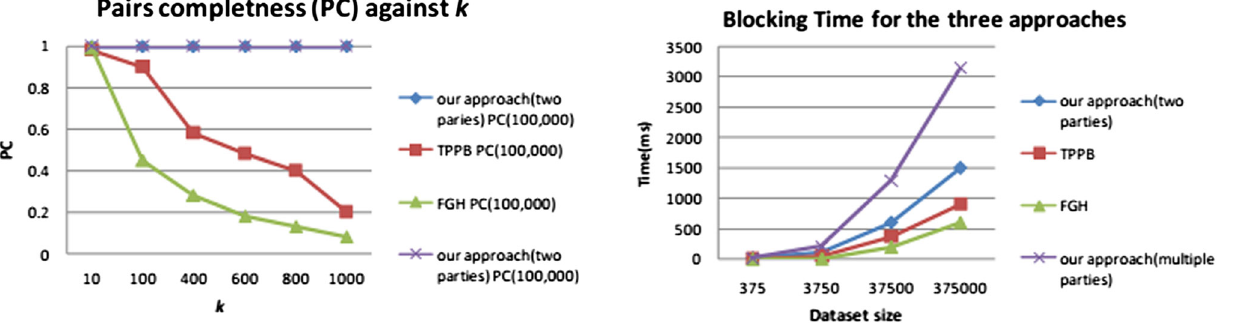
Fig. 7 PC with different values for k , dataset size = 100,000